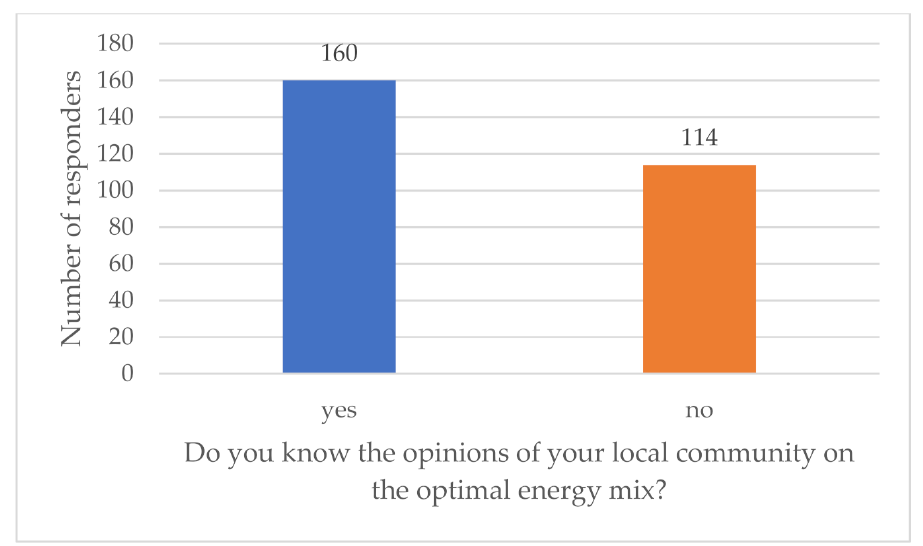
Figure 13. Knowledge of concepts and phenomena. Respondents could select only one answer—‘yes’ or ‘no’. Source: own study.